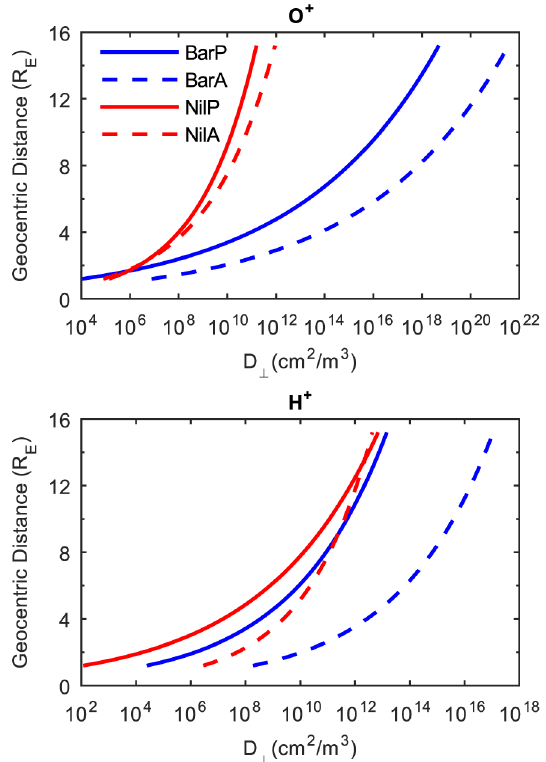
Figure 2. Perpendicular velocity diffusion coefficient profiles for O + (top panel) and H + (bottom panel) ion species. BarP refers to diffu- sion coefficients calculated by Barghouthi et al. [1998] (Equation 4). BarA refers to the diffusion coefficients calculated by Barghouthi [1997] (Equation 5). NilP and NilA refer to diffusion coefficients in the central polar cap and cusp respectively calculated by Nilsson et al. [2013] (Equations 6 and 7